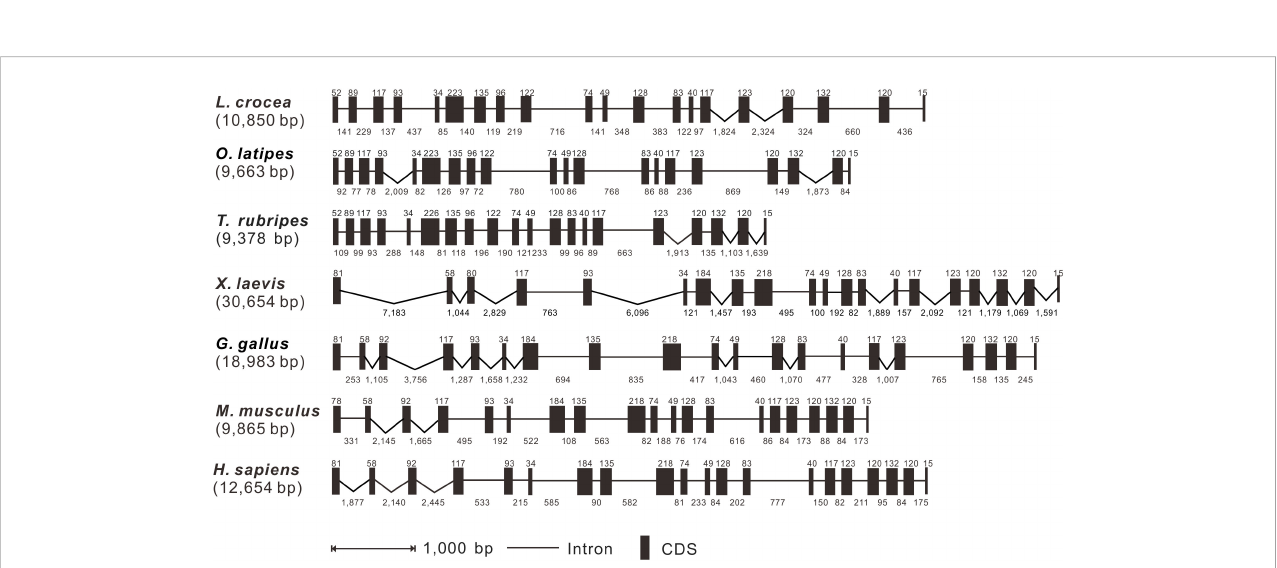
FIGURE 2 Genomic organization comparison of Lc - TRAF7 with other vertebrates. Comparison of exons and introns of TRAF7 gene in L. crocea , O. latipes , T. rubripes , X. laevis , G. gallus , M. musculus , and H. sapiens . Black boxes indicate the exons with the length in base pairs (bp) shown above the black boxes. The lines represent the introns with the lengths in bp shown below the lines. Gene sequences information and their GenBank association numbers are shown as follows: L. crocea , NC_040022.1 (12369484-12384469); O. latipes , NC_019866.2 (23006181-23019805); T. rubripes , NC_042289.1 (2970858- 2983898); X. laevis , NC_054388.1 (102661726-102704069); G. gallus , NC_052545.1 (6421549-6450335); M. musculus , NC_000083.7 (24727824- 24746912); H. sapiens , NC_000016.10